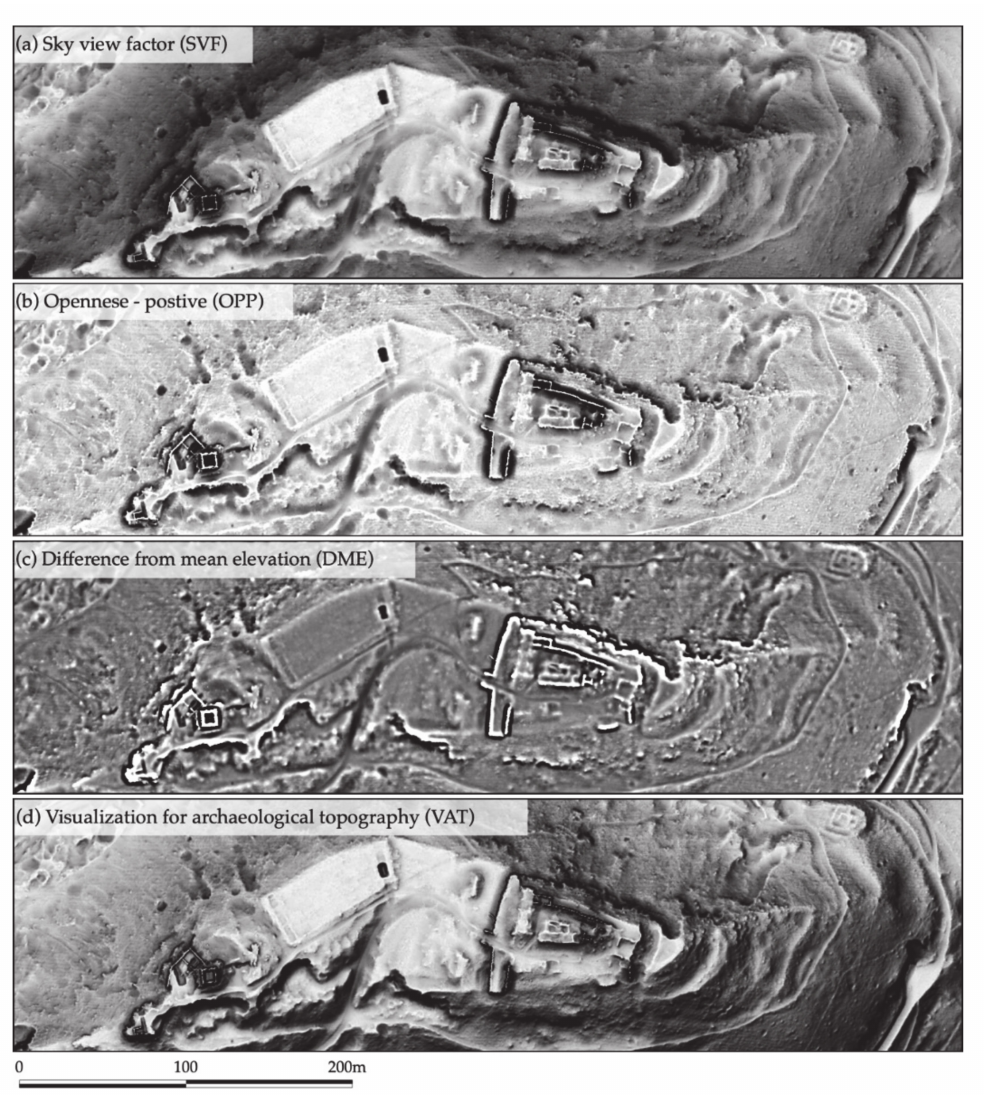
Figure 17. Test site AT, DFM visualization techniques included in the pipeline: ( a ) sky view factor (SVF); ( b ) Openness– positive (OPP); ( c ) Difference from mean elevation (DME); ( d ) Visualization for archaeological topography